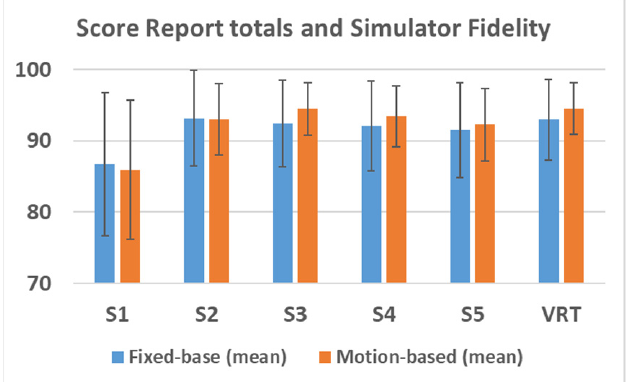
Figure 12. Simulator fidelity comparison.